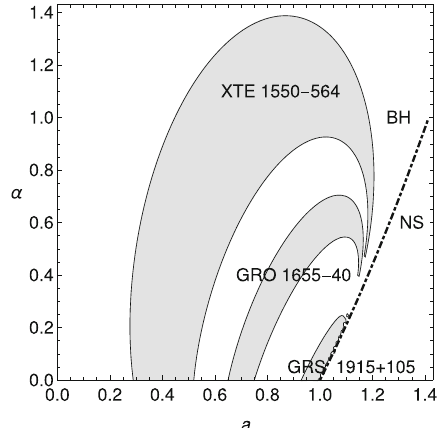
Fig. 2 Estimation of BH rotation parameter a for different values of Kerr-MOG parameter α . Spectral continuum fitting for three micro- quasars restrict allowed regions (gray) of BH spin a and α parameter by energy condition (22), dashed line separate BH and naked singularity spacetime